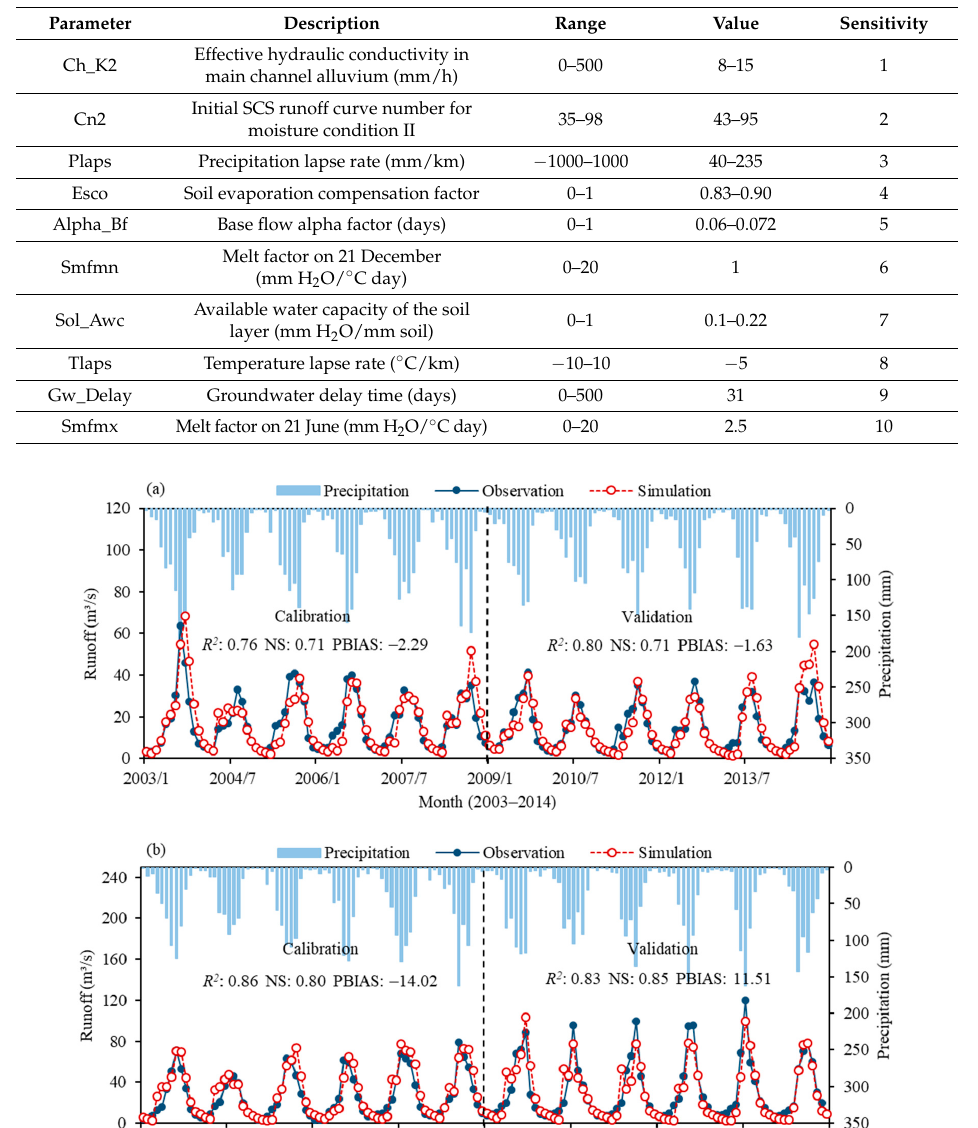
Table 2. Most sensitive parameters.